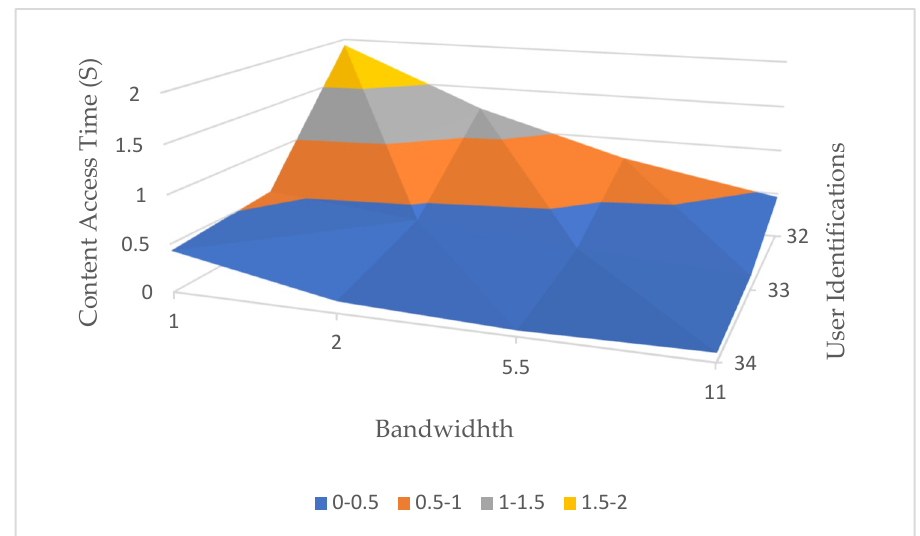
Figure 13. Impact of duplicate content in caching.